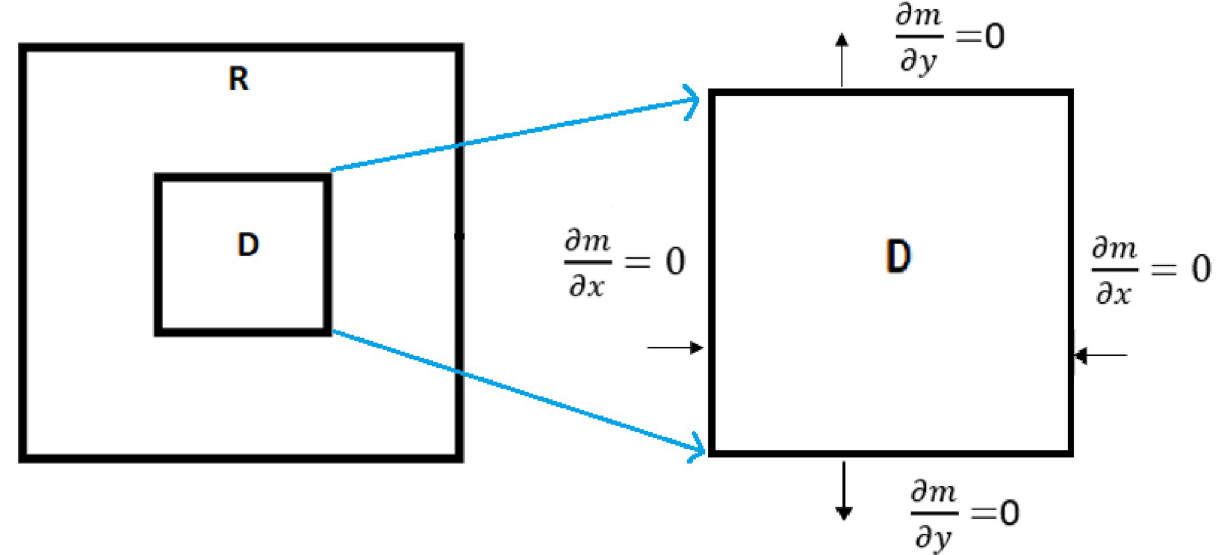
Fig 3. Lung geometry with damage area. The alveolar air space is not considered in the lung geometry. The domain R has a damaged area D . The boundary conditions have zero flux. We consider the area of inflammation for a mild case of IPF, namely I namely, I D = 0.5 × 0.5 cm 2